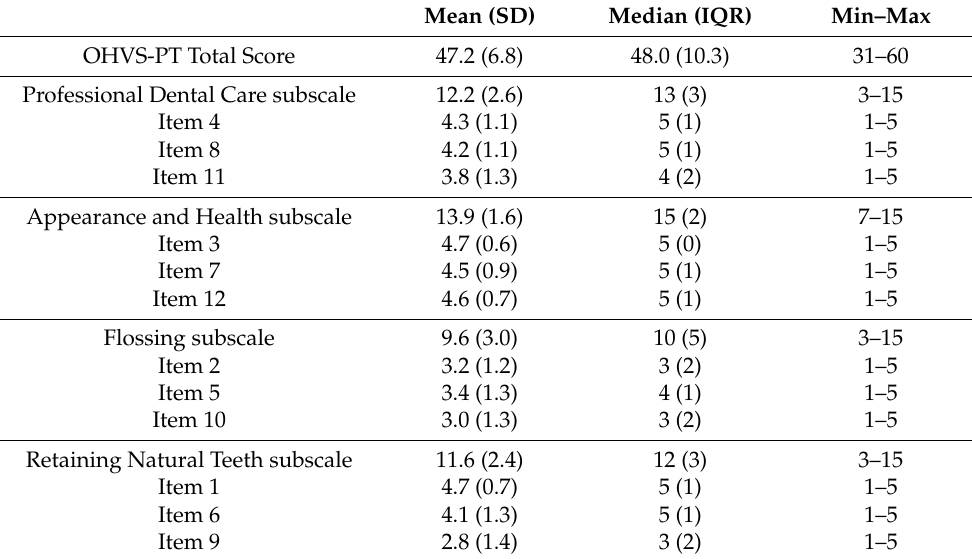
Table 4. Descriptive statistics of OHVS scores (mean, standard deviation (SD), median and interquar- tile range (IQR), minimum and maximum).